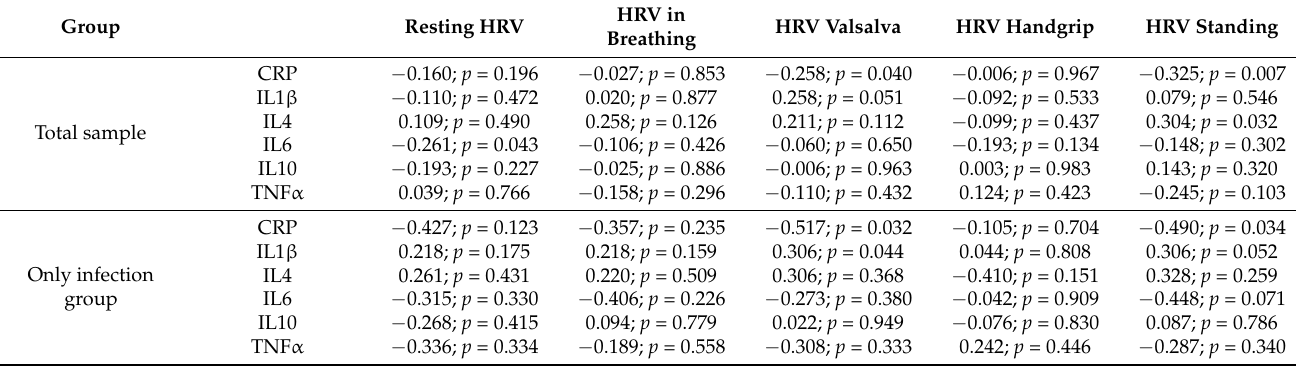
Table 3. Spearman’s correlation coefficients and p -values for the week 1 within-subject association between the heart-rate variability (HRV) and inflammatory markers 1